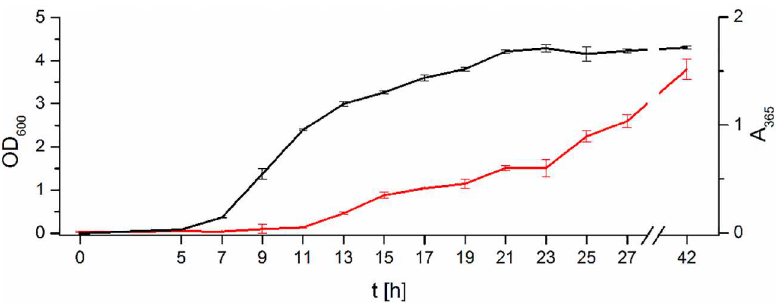
Fig 3. Growth curve of P . aurantiaca PB-St2 and production curve of phenazines. The growth curve of P . aurantiaca PB-St2 was measuredas OD 600 (black) and the productioncurve of phenazines as A 365 (red). Data represent means with corresponding standard deviationof three